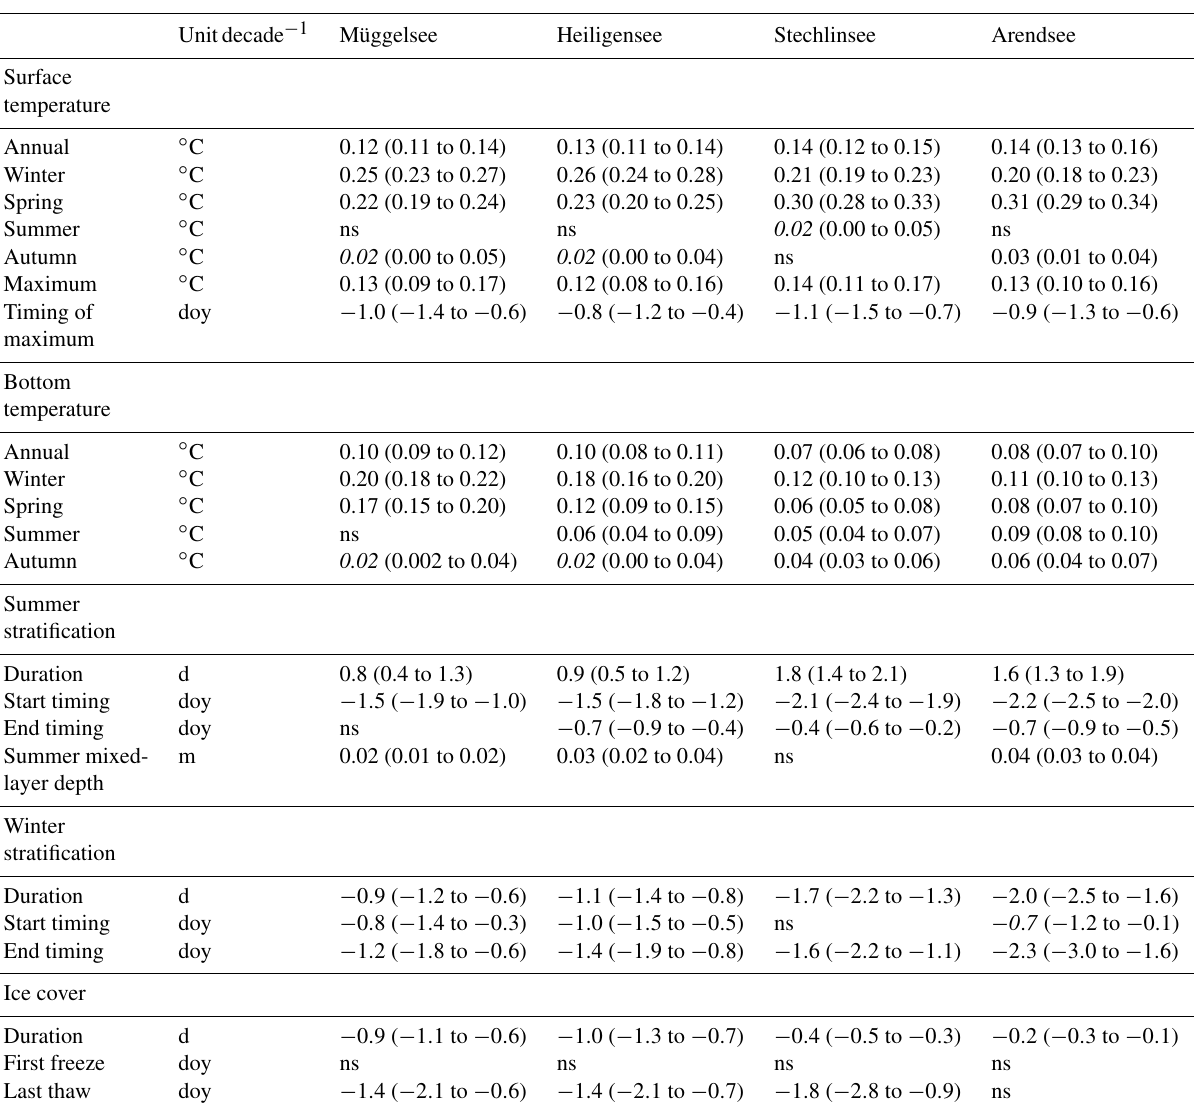
Table 3. Projected trends (2006–2100) in lake temperature and stratification characteristics, with 95% confidence intervals in parentheses. Italics denote trends with 0.01< p <0.05; all other trends are significant at p <0.001; doy: day of the year; ns: not